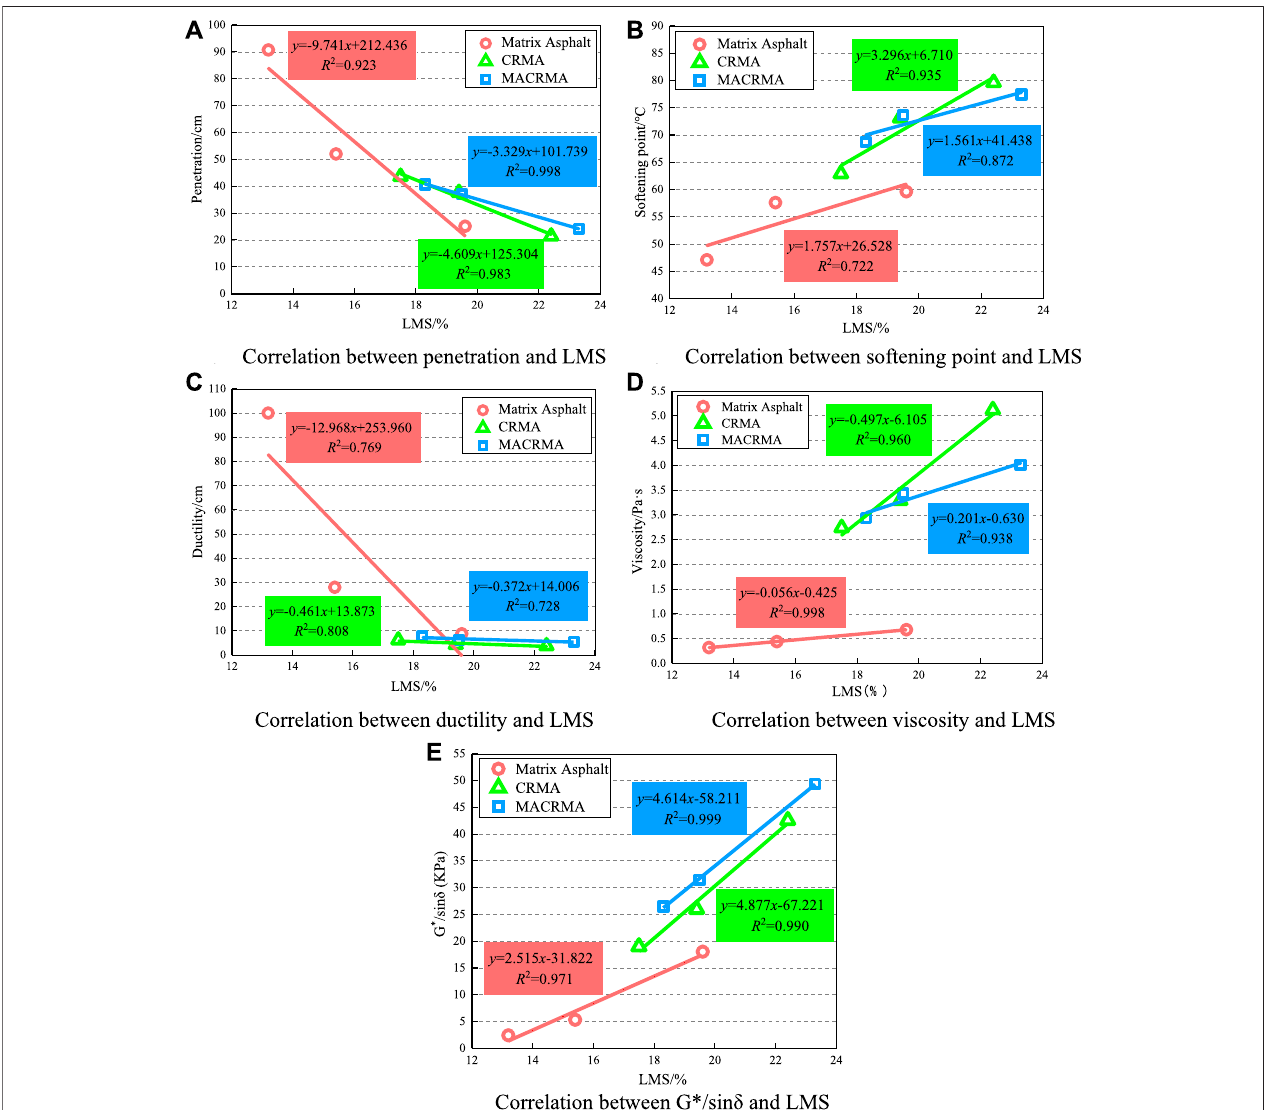
FIGURE 8 | Correlation analyses between test indicators and LMS. (A) Correlation between penetration and LMS, (B) Correlation between softening point and LMS, (C) Correlation between ductility and LMS, (D) Correlation between viscosity and LMS, (E) Correlation between G*/sin δ and LMS.